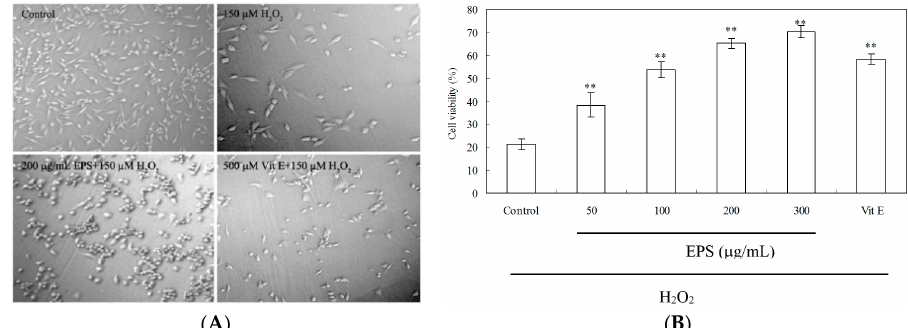
Figure 8. The protective effect of EPS on H 2 O 2 ‐ induced damage in PC12 cells. ( A ) Cell morphology,